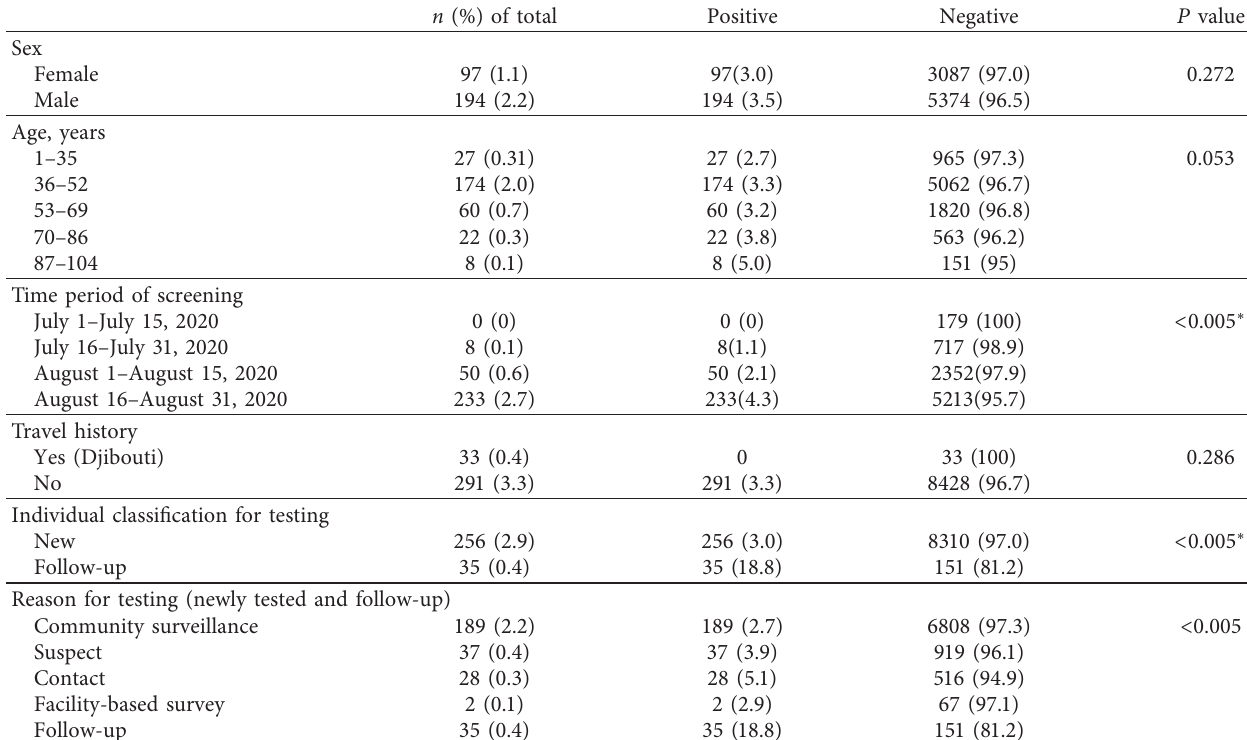
Table 2: Prevalence of COVID-19 infection among study participants in the northeastern region of Ethiopia, 2020. n (%) of